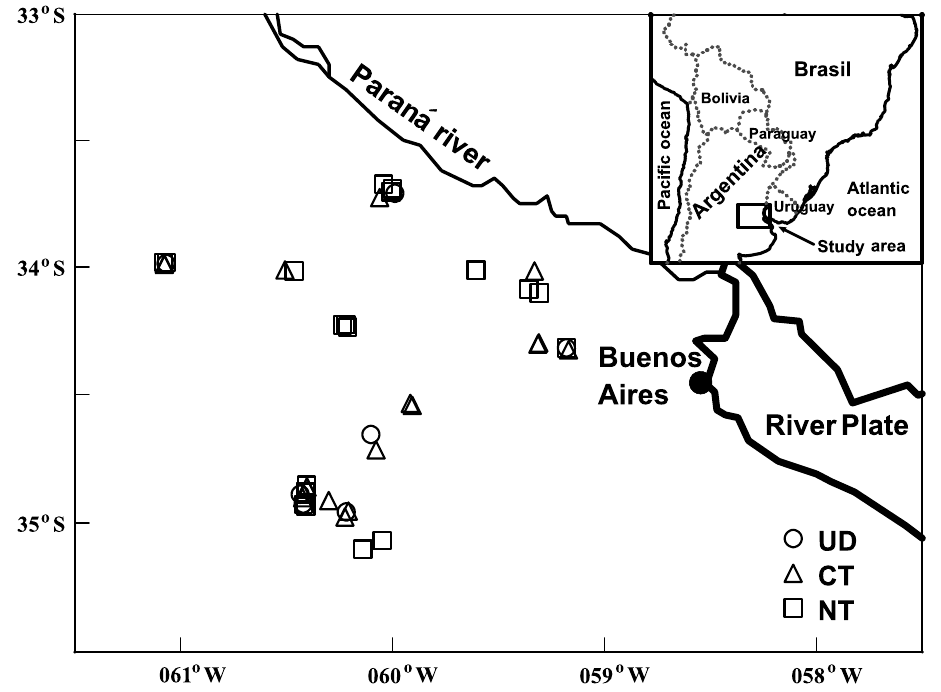
Figure 1. Location of the studied sites. Undisturbed (UD), no tilled (NT) and conventionally tilled (CT)